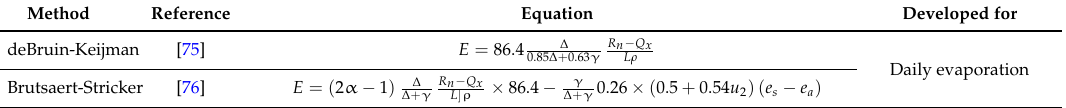
Table 2. Selected evaporation method for comparison with the proposed